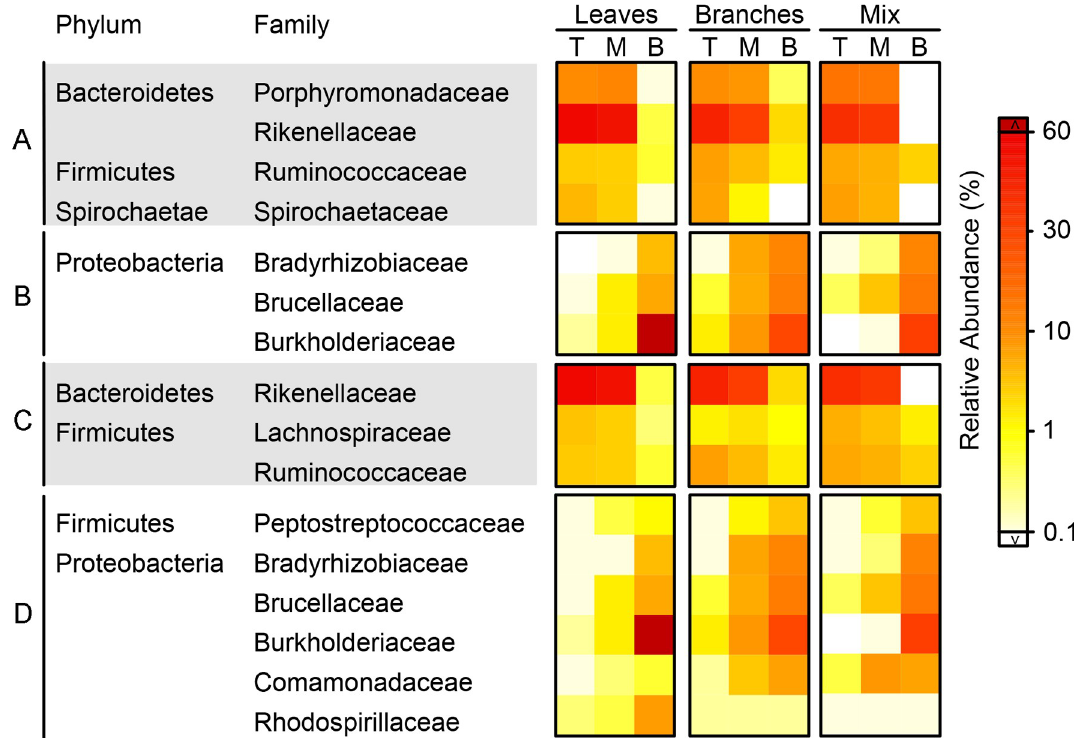
Fig 5. Heatmap of selected bacterial lineages at different decomposition stages of fungus-combs. There are four groups of bacterial lineages: A, enriched (RA > 5%) in fresh comb of three food treatments; B, enriched (RA > 5%) in mature comb of three food treatments; C, showed preference in fresh comb of specific food treatment(s); D, showed preference in mature comb of specific food treatment(s). T, M, and B described in Table 1.